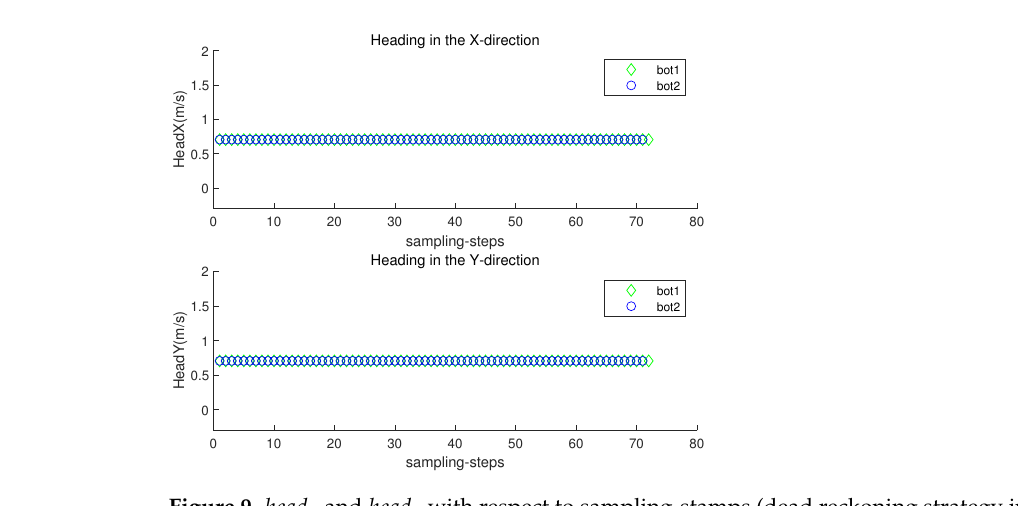
Figure 9. head x and head y with respect to sampling-stamps (dead reckoning strategy in Scenario 1).